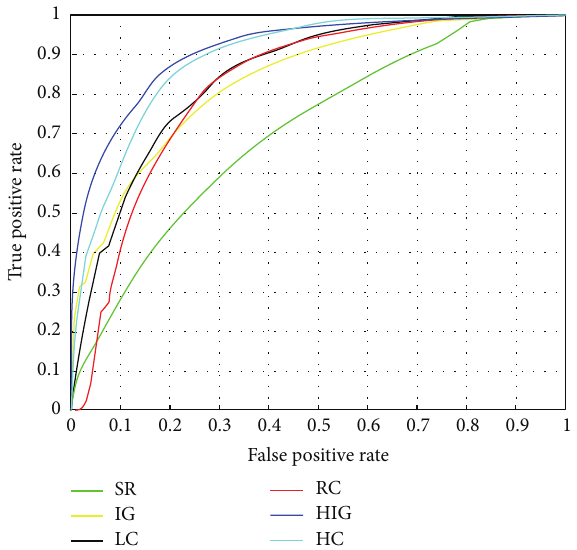
Figure 4: FPR-TPR curves for different visual saliency detection algorithms: HC [17], LC [11], RC [17], SR [12], IG [14], and HIG in the experiments.